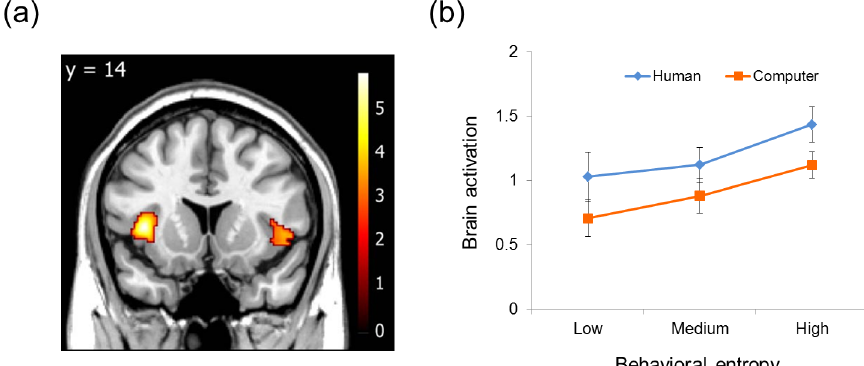
Fig 5. (a) Bilateral anterior insula activity positively correlated with behavioral entropy (obtained from the parametric analyses in the first GLM). Within the insula ROIs, the statistical threshold was set at p < 0.005 (uncorrected) and cluster p < 0.05 (corrected). ( b ) The mean of the left anterior insula activities (beta-values) obtained from the second GLM by each entropy degree and opponent. Beta-values were extracted from the peak voxel identified by the first GLM.